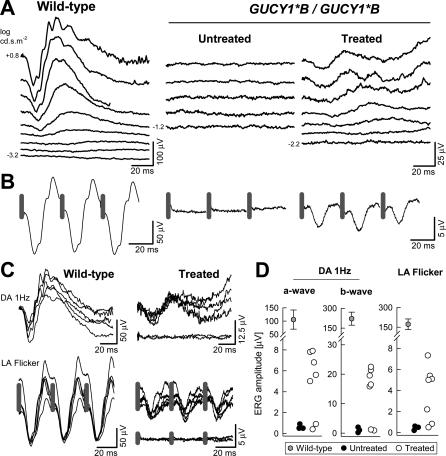
Retinal Electrophysiology Rescued in Treated Eyes(A) Comparison of dark-adapted ERGs in response to increasing intensities of light in a GUCY1*B/GUCY1*B animal injected with EF1α-bGC1-IRES-eGFP (“treated”) compared to a control animal (“untreated”). ERGs in the untreated animal are nondetectable, in contrast to the sizeable ERGs evoked in the treated animal. Results from a wild-type animal are shown in the left column for comparison.(B) Light-adapted 29-Hz flicker ERGs in the same animals as shown in (A) demonstrate restoration of responses after treatment.(C) Overlapping waveforms are ERGs elicited by 0.8 log cd·s·m−2 white flashes presented in dark-adapted (“DA 1 Hz”) and light-adapted (“LA Flicker”) states in all treated animals compared to wild-type controls. Functional rescue was observed in five (top waveforms) of the seven treated animals, whereas two (bottom waveforms) showed responses indistinguishable from noise.(D) Summary parameters of dark-adapted photoreceptor (a-wave) and post-photoreceptor (b-wave) function, as well as light-adapted flicker amplitude in treated animals as compared to untreated and wild-type animals. Five of seven treated animals showed amplitudes substantially larger than untreated animals but smaller than wild-type controls (gray symbols; mean ± standard deviation).